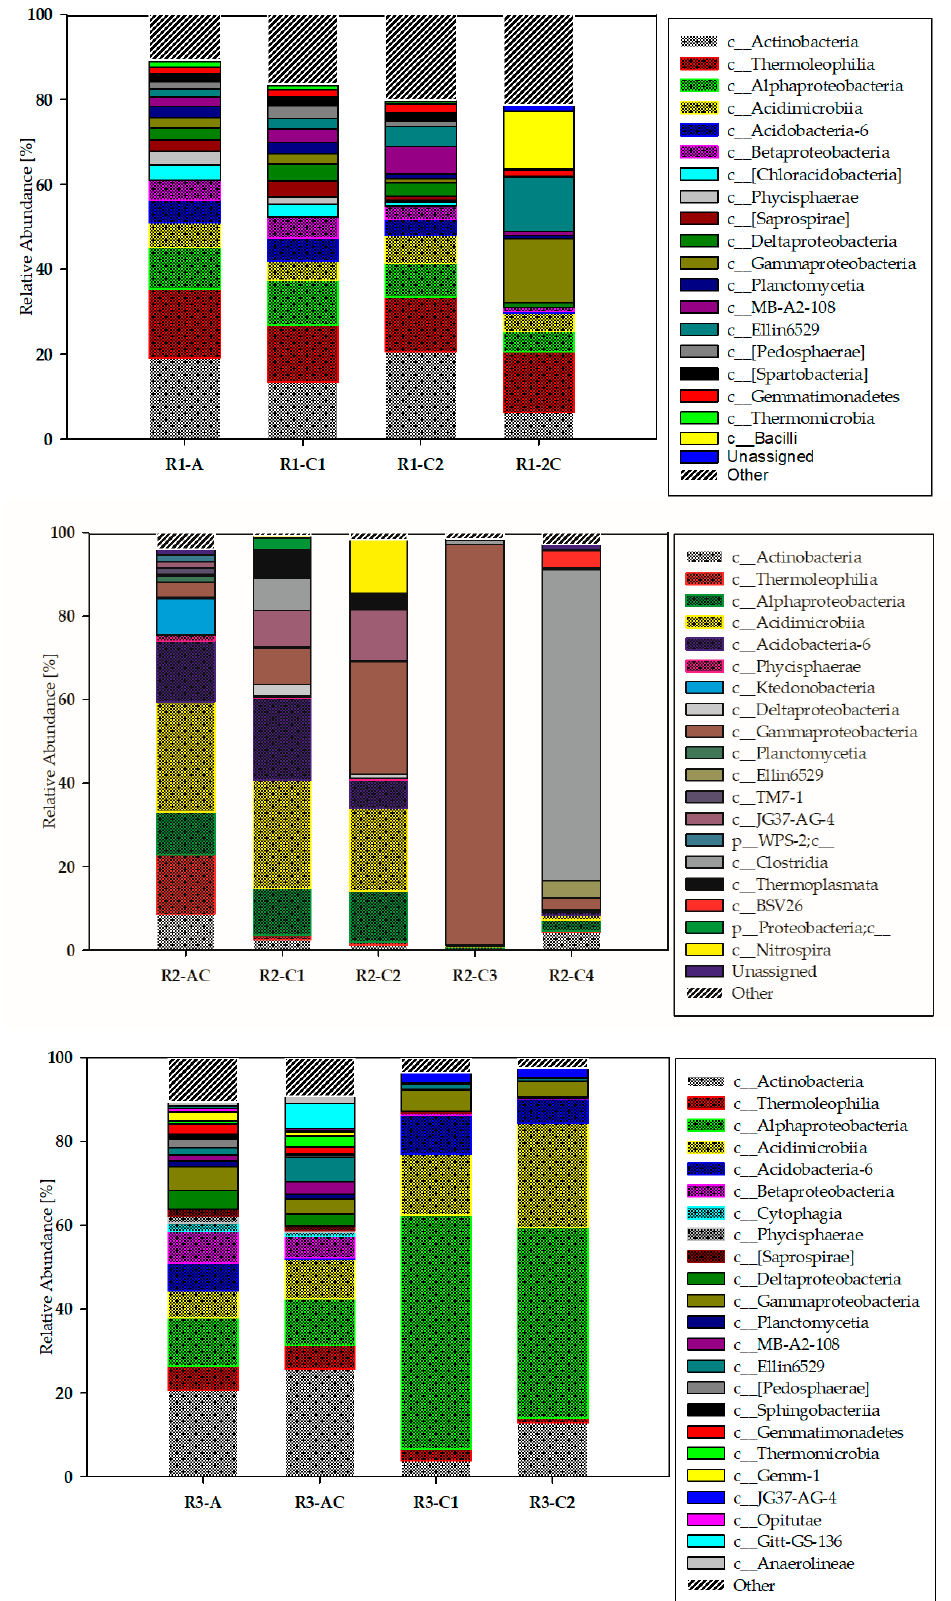
Figure 2. Main classes of bacteria identified in the studied soils profiles (R1, R2 and R3) and horizons (A, AC, C1, C2, C3, C4, 2C).